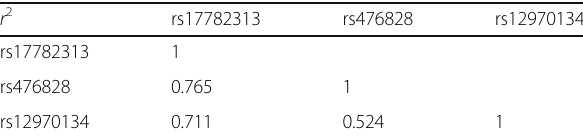
Table 3 Degree of linkage disequilibrium between the MC4R SNPs and the combined population of obesity and control